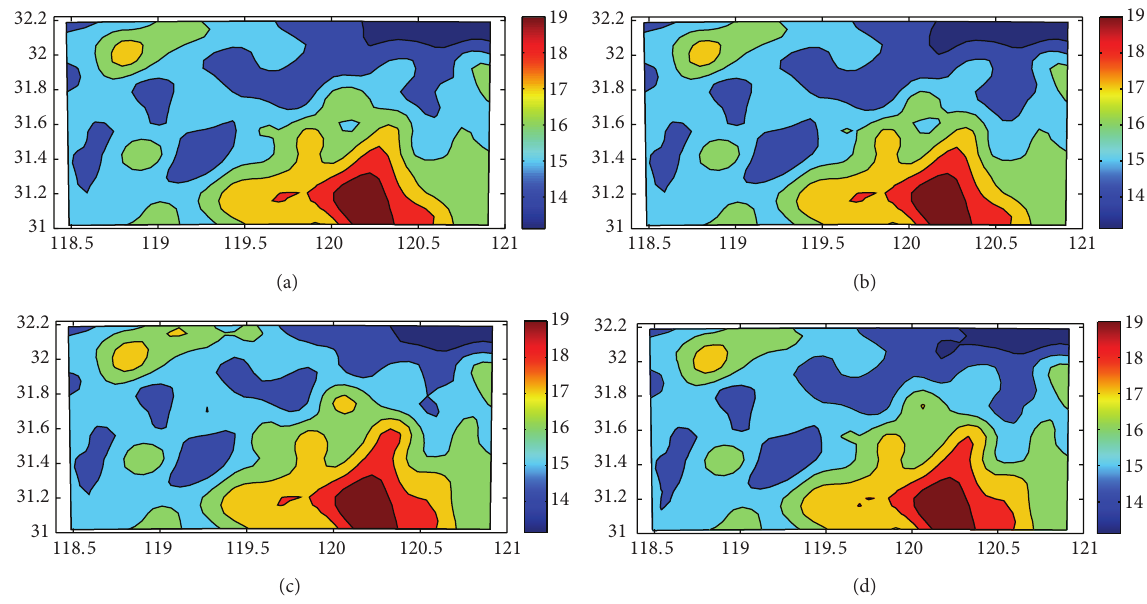
Figure 6: Spatial pattern of the monthly average temperature in Southern-Jiangsu under different scenarios (unit: ∘ C). (a) and (b) show the simulation result of average temperature of land use in Southern-Jiangsu in year 2010 under REG scenario and CES scenario, respectively; (c) and (d) show the simulation result of average temperature of land use in Southern-Jiangsu in year 2050 under REG scenario and CES scenario,